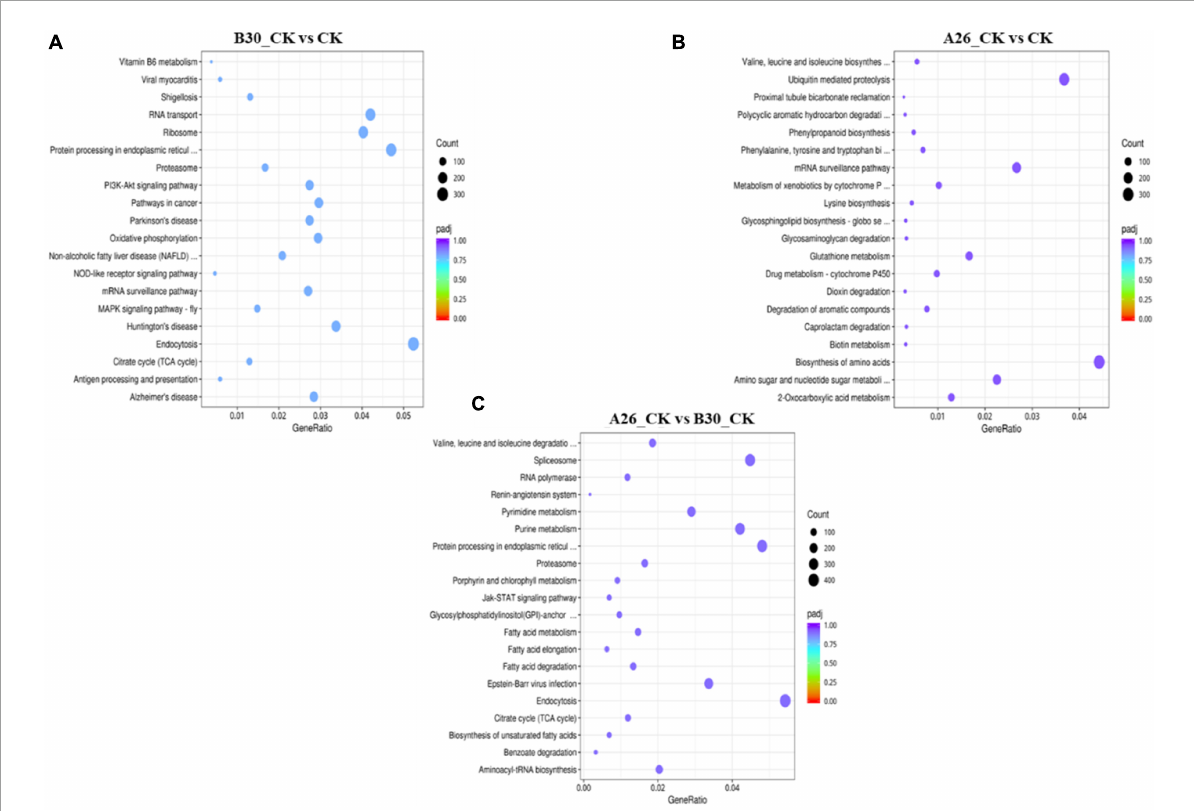
FIGURE10 Kyoto encyclopedia of genes and genomes (KEGG) enrichment scatter plot of DEGs, (A) Top 20 enriched pathways of B30_CKvsCK (B) A26_CKvsCK (C)